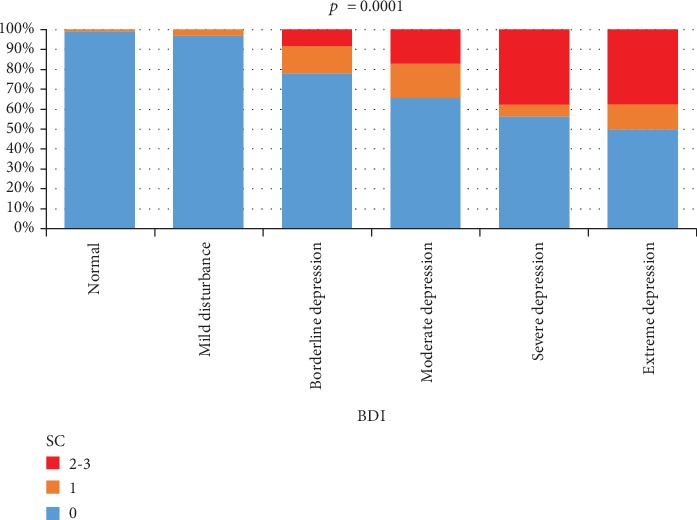
The relationship between SC and BDI score. Normal: <10 points, mild disturbance: 11-16 points, borderline depression: 17-20 points, moderate depression: 21-30 points, severe depression: 31-40 points, and extreme depression: >40 points.